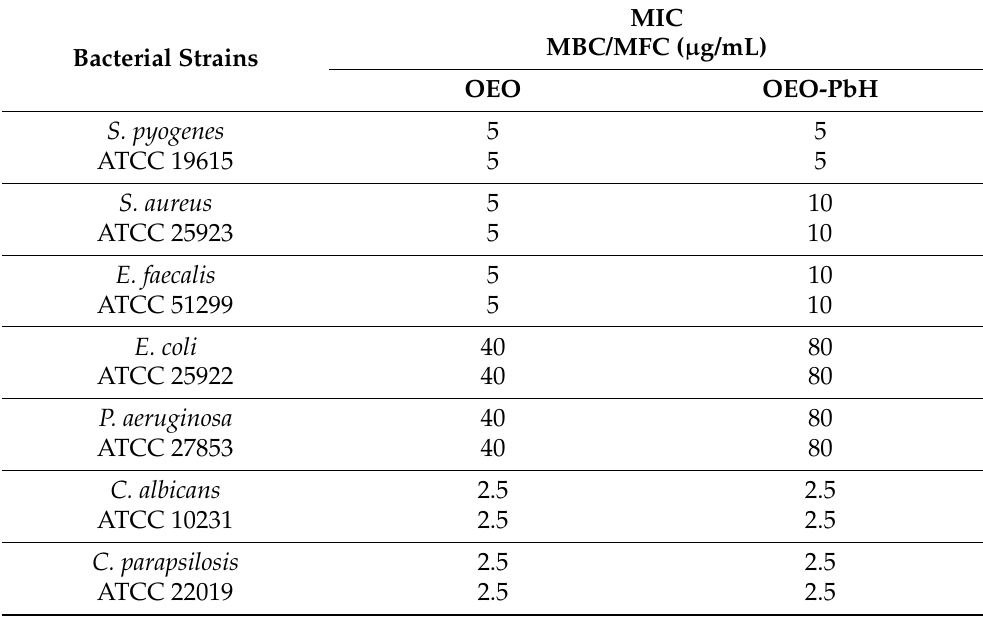
Table 4. Antimicrobial activity of OEO and OEO-PbH.